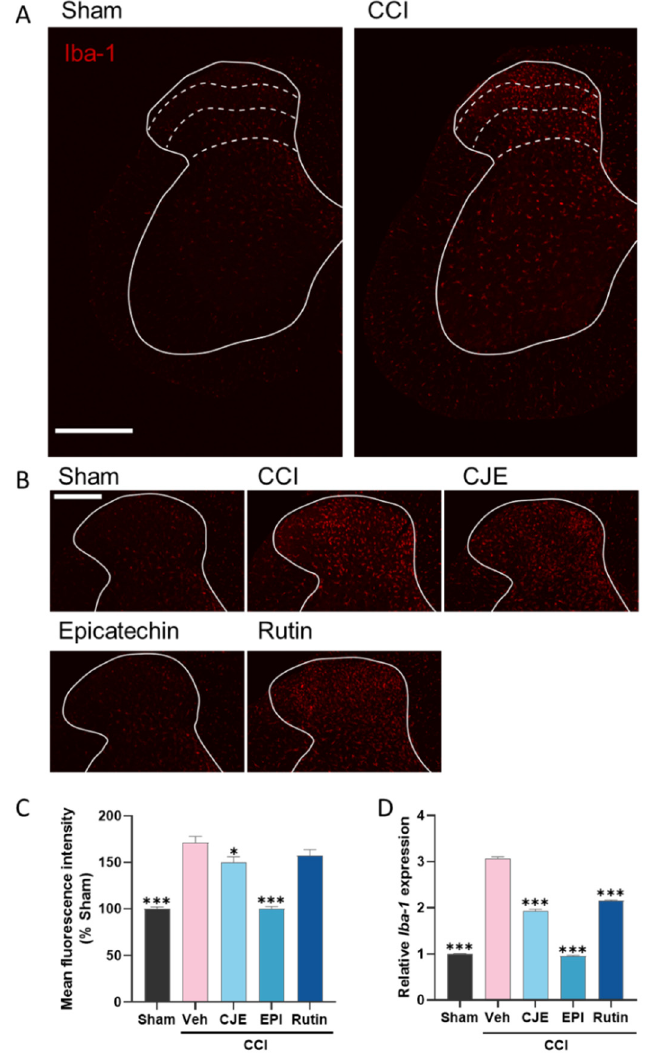
Figure 7. Effect of oral administration of CJE, ( − )-epicatechin, and rutin on the microglial marker, ionized calcium-binding adaptor molecule allograft inflammatory factor 1 (Iba-1), in the spinal cord in the CCI model. ( A ) Representative confocal immunofluorescence images of the ipsilateral dorsal horn of the spinal cord immunostaining of Iba-1 in the sham and CCI groups 3 days postoperatively. The scale bar denotes 500 µ m. ( B ) Magnification of the confocal immunofluorescence images of the ipsilateral dorsal horn of the spinal cord immunostaining of Iba-1 in the sham, CCI, CJE, ( − )- epicatechin, and rutin treatment groups. The scale bar denotes 300 µ m. ( C ) Quantification of the mean fluorescence intensity of Iba-1. ( D ) The mRNA expression of Iba-1 was detected by qRT-PCR in the DRG. Data are presented as the mean ± SEM of three independent experiments and analyzed using one-way ANOVA; * p < 0.05, *** p < 0.001 compared with CCI with the vehicle treatment